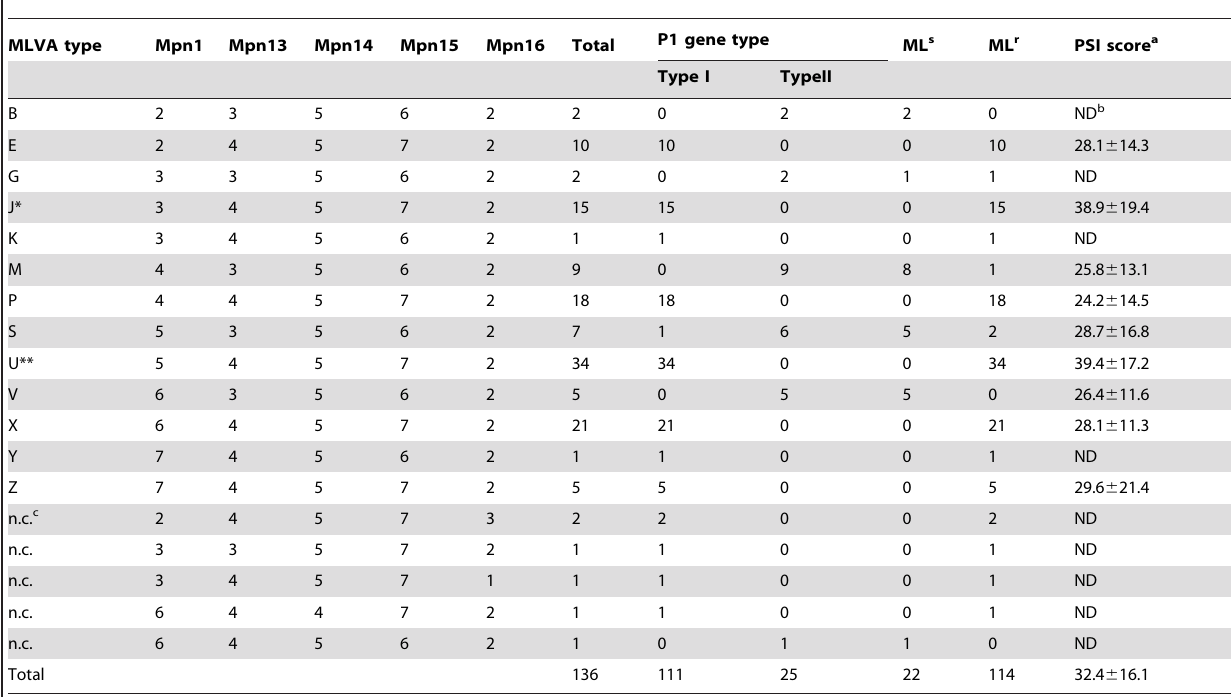
Table 2. Results of MLVA and P1 gene types according to macrolide susceptibility and comparison of PSI scores among CAP